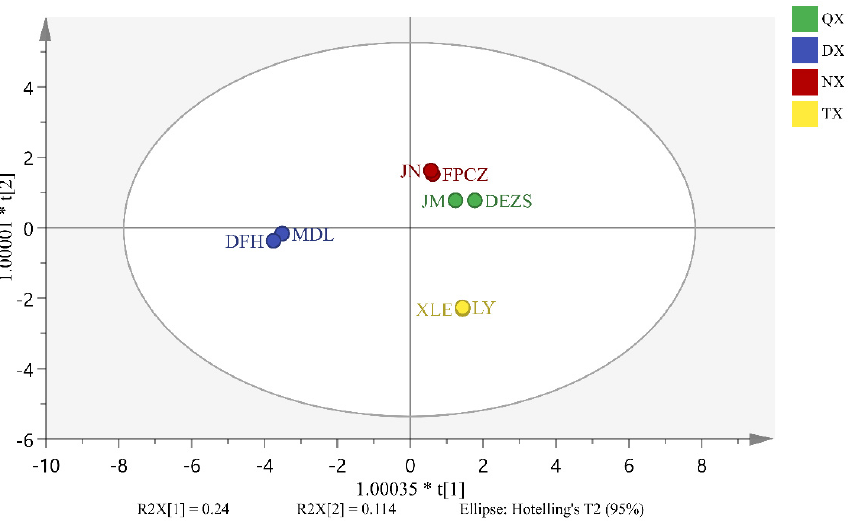
Figure 5. Score plot of OPLS-DA models of endogenous extracts of P. mume cultivars with the sta-